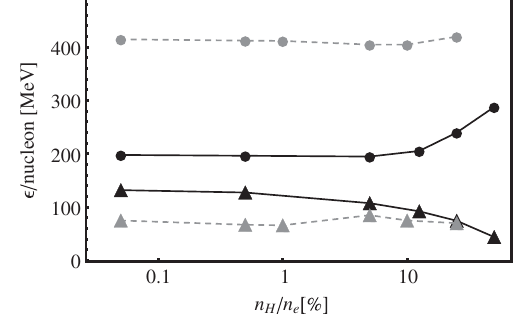
FIG. 6. Maximum proton (dots) and carbon ion (triangles) energies versus hydrogen concentration for the target electron density 200 n c and thickness l ¼ 0 . 12 λ (black curves) and for low-density targets with n e ¼ 20 n c and l ¼ 6 λ (gray dashed